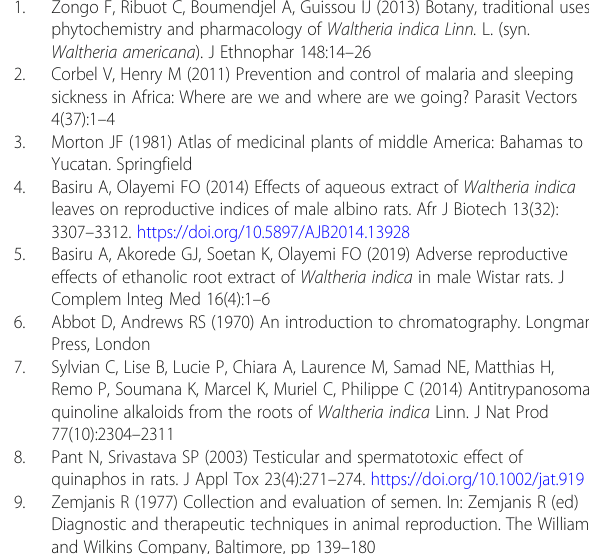
Values are significantly different from control values DF1 to DF7 are the chromatographic fractions 1 – 7 obtained from chromatographic analysis of dichloromethane fraction of Waltheria indica Linn . root C control, T testosterone * p < 0.05, † p < 0.01, ‡ p <